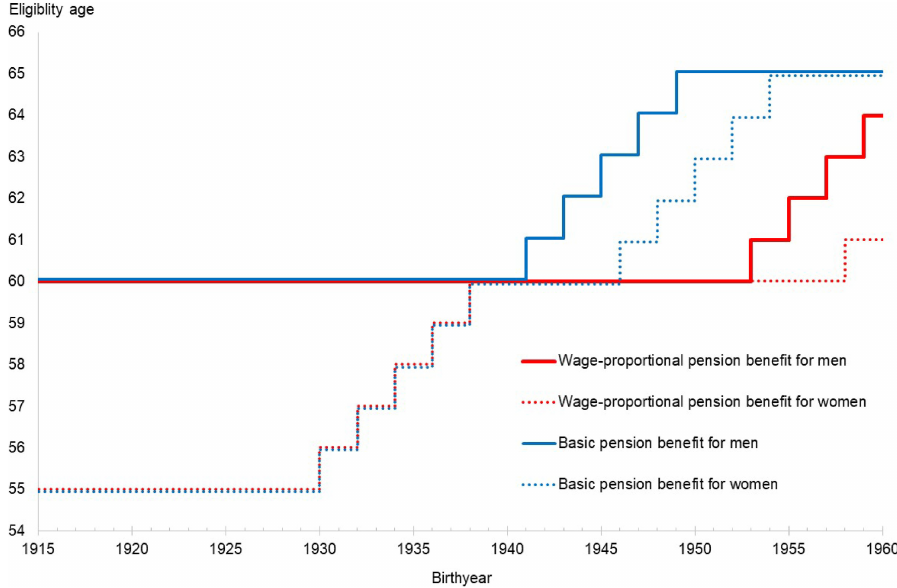
Figure 1. Eligibility ages for public pension bene fi ts by sex and birth